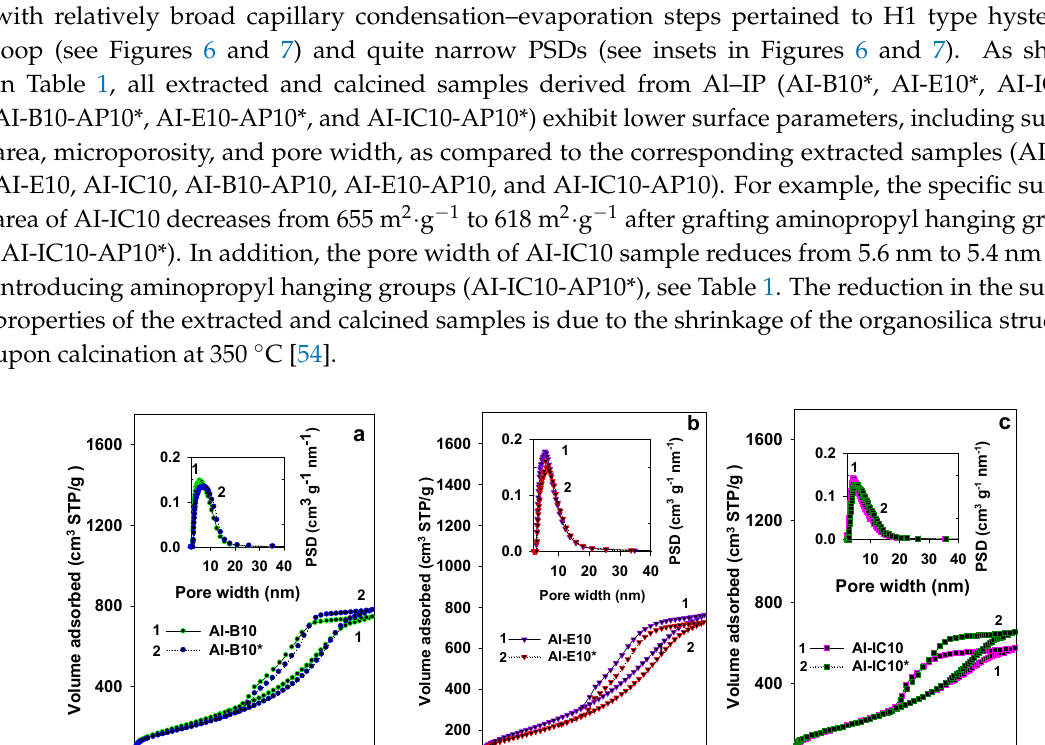
0.0 0.2 Relative pressure Figure 6. N 2 adsorption isotherms and their respective PSD curves (insets) for the extracted (AI-B10 (left panel a ), AI-E10 (middle panel b ), and AI-IC10 (right panel c )), and extracted calcined (AI-B10* (left panel a ), AI-E10* (middle panel b ), AI-IC10* (right panel c )) samples, where B, E, and IC refer to benzene, ethylene, and isocyanurate bridging groups, respectively; AI refers to aluminum isopropoxide.